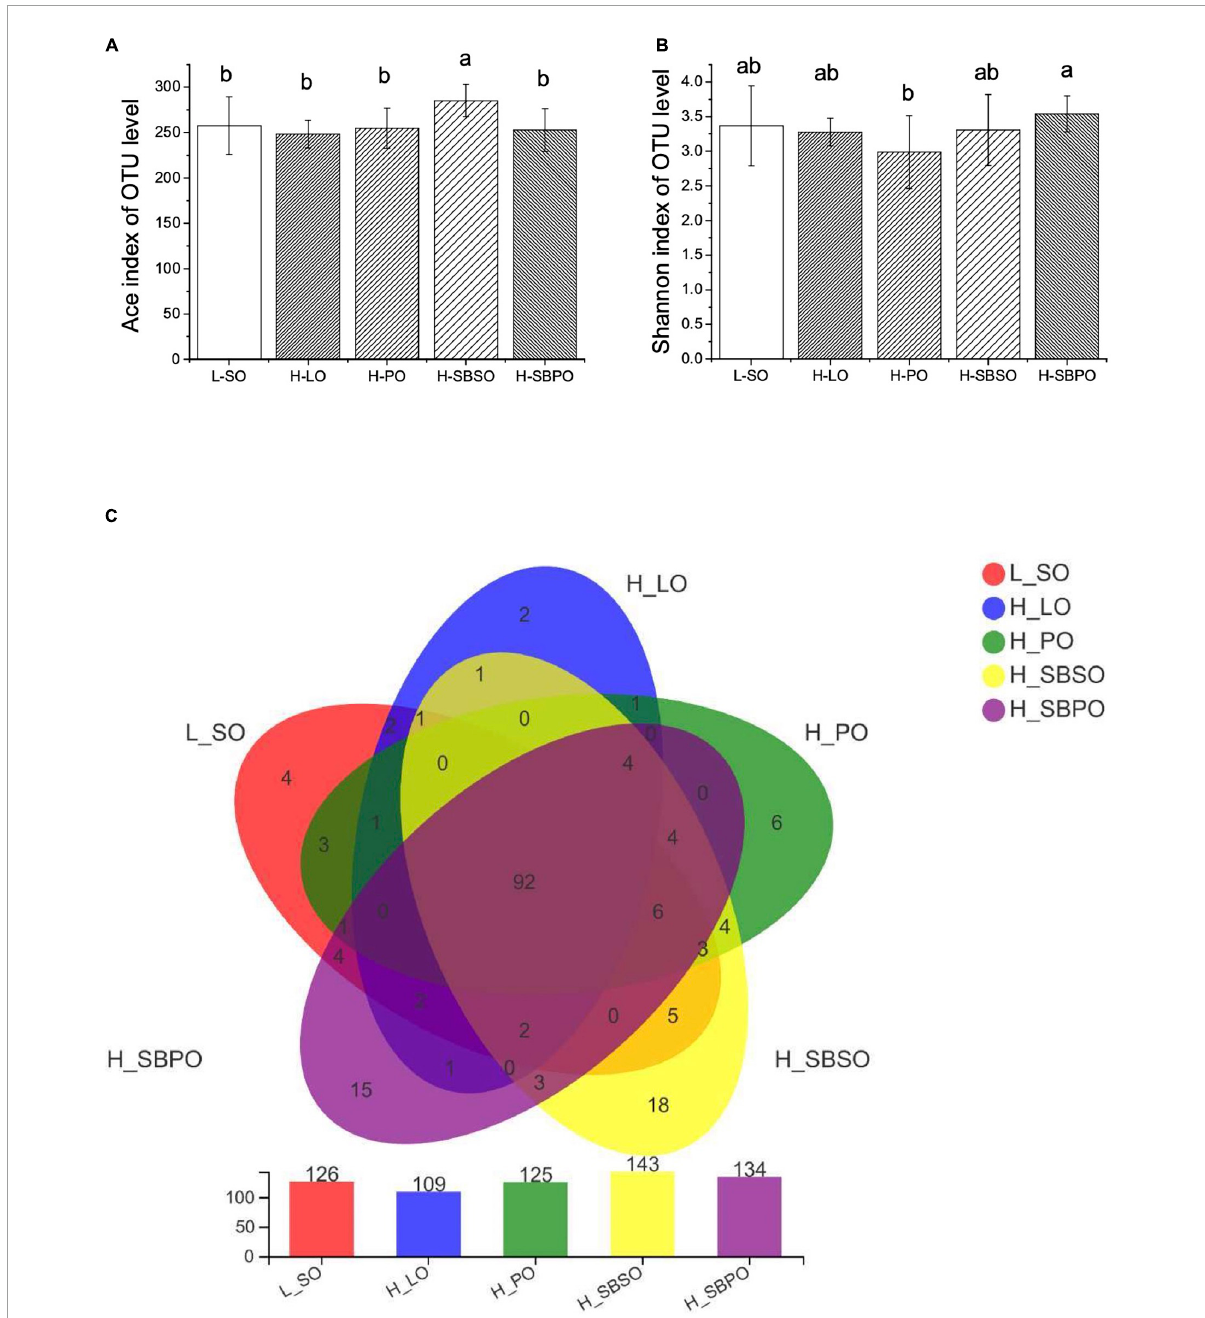
FIGURE4 α -Diversity of gut microbiota illustrated by (A) Ace index, (B) Shannon index, and (C) Venn diagram of gut microbiota at OTU level ( n = 11–12). L-SO, low-fat diet with soybean oil; H-LO, high-fat diet with lard oil; H-PO, high-fat diet with peanut oil; H-SBSO, high-fat diet with sea buckthorn seed oil; H-SBPO, high-fat diet with sea buckthorn pulp oil. Different letters (a and b) indicate significant differences ( P < 0.05) of mice gut microbiota α -diversity (reflected by Ace and Shannon index) between each